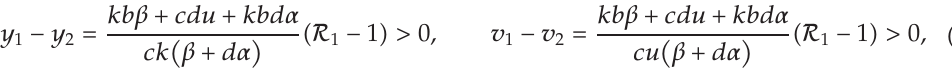
system (cid:2) 1.2 (cid:3) has a CTL-activated infection equilibrium E 2 besides E 0 and E 1 , which is